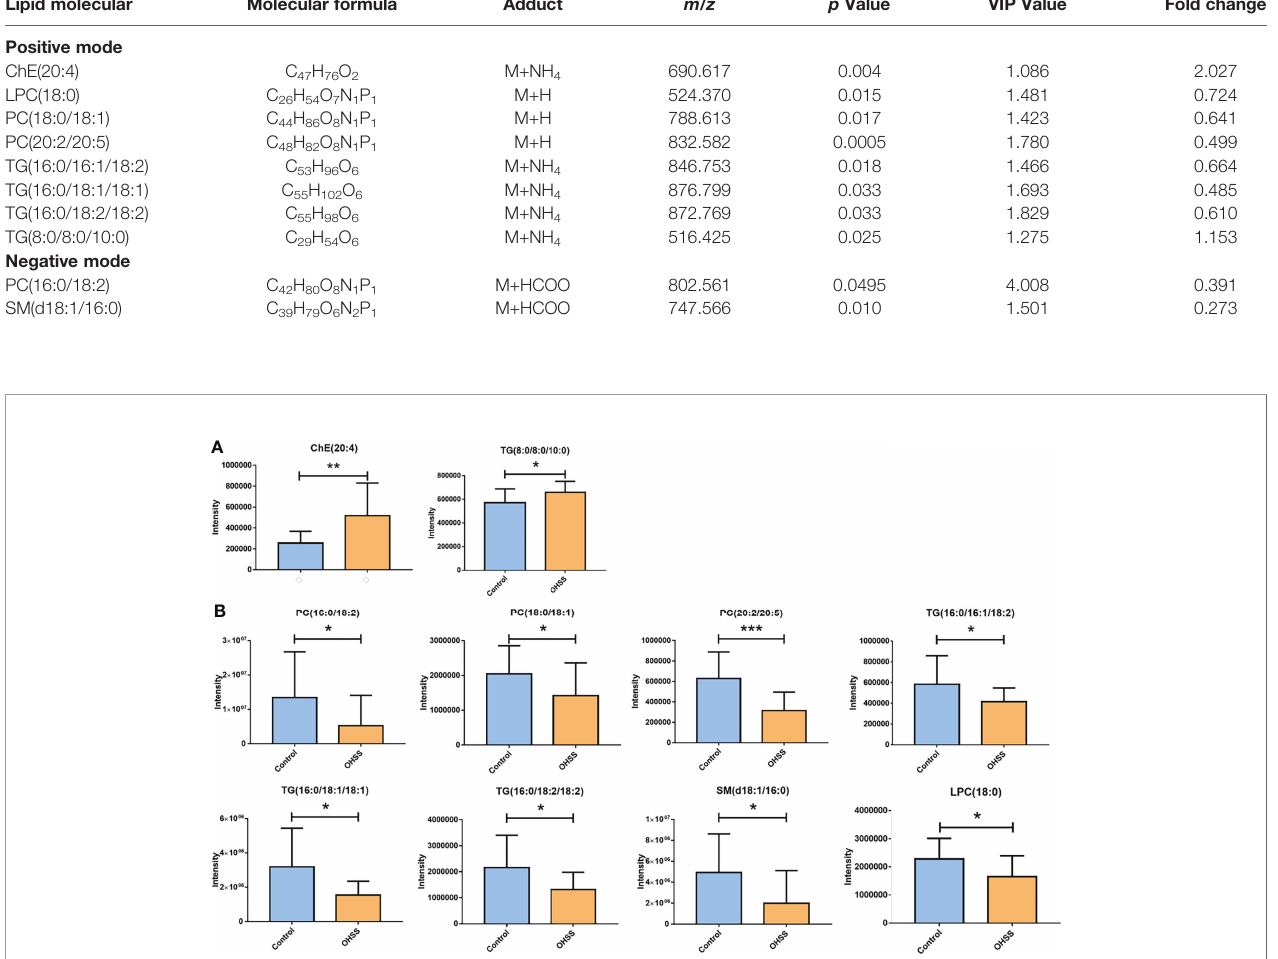
TABLE 2 | Detailed information of signi fi cantly changed lipids between OHSS patients and healthy controls. Lipid molecular Molecular formula